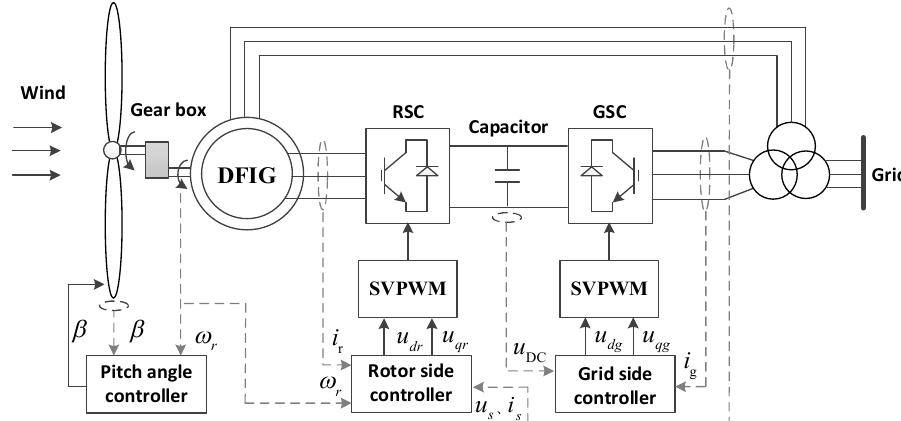
Figure 1. The block diagram of DFIG WT model.